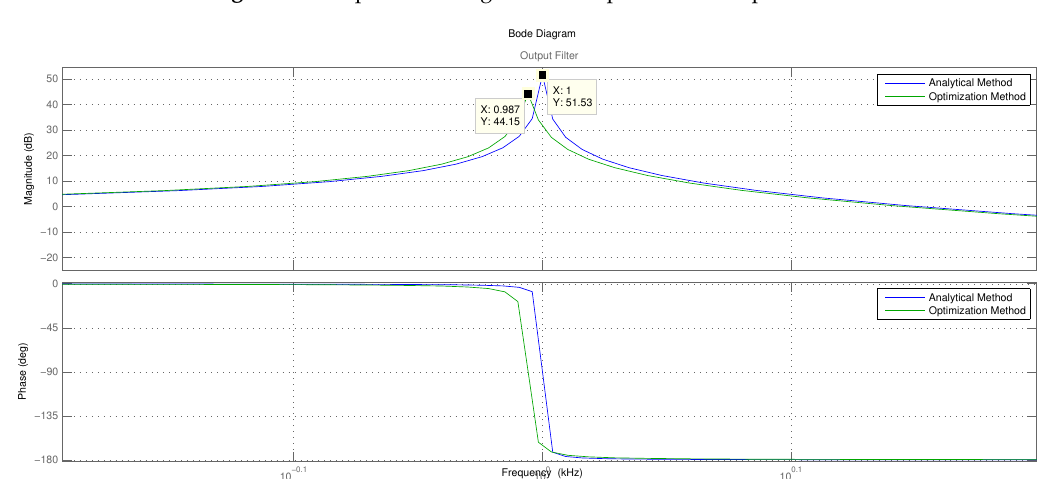
Figure 13. Graph of the magnitude and phase of the input filter.